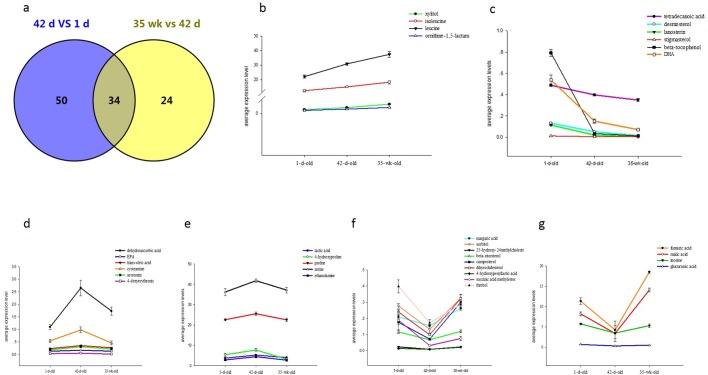
The co-altered metabolites in both brooding and growing periods which have different variation tendency. (A) Venn diagram analysis of the metabolic profiles of livers among different ages; (B) continually increased metabolites; (C) continually decreased metabolites throughout the brooding and growing periods; (D,E) metabolites which were increased during brooding period but decreased during growing period; (F,G) metabolites which were decreased during brooding period but increased during growing period. Error bars represent the standard error values of relative abundance of metabolites among five liver samples.